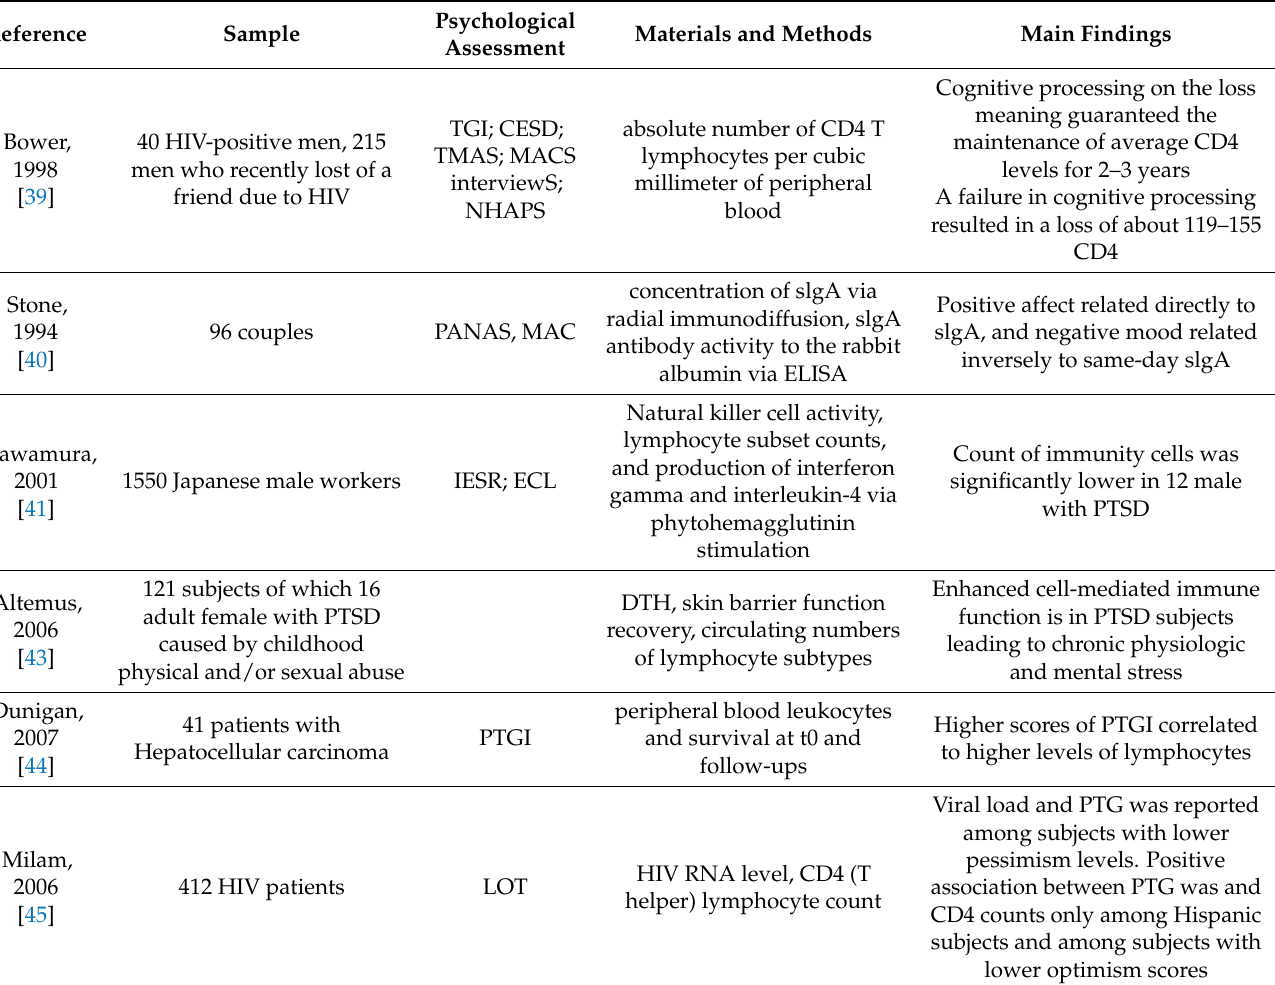
Table 3. Immunological